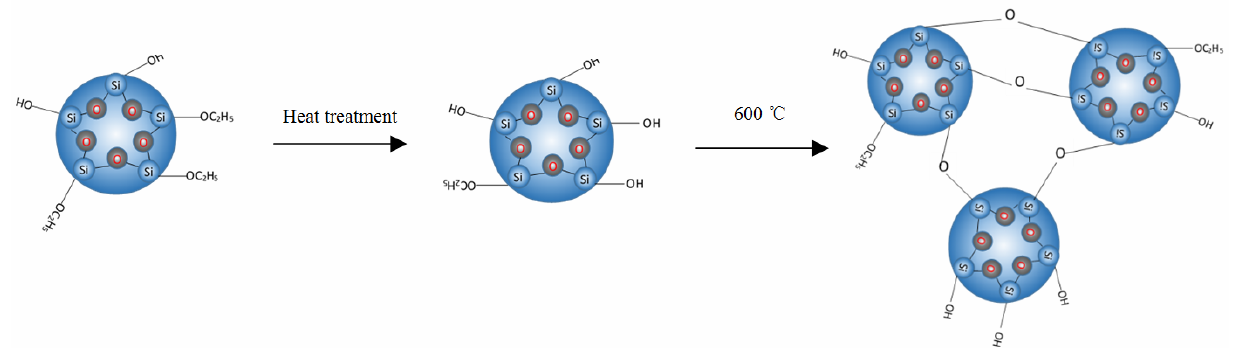
Fig. 2 Schematic view of the formation of additional Si–O–Si bonds in aerogels after a thermal